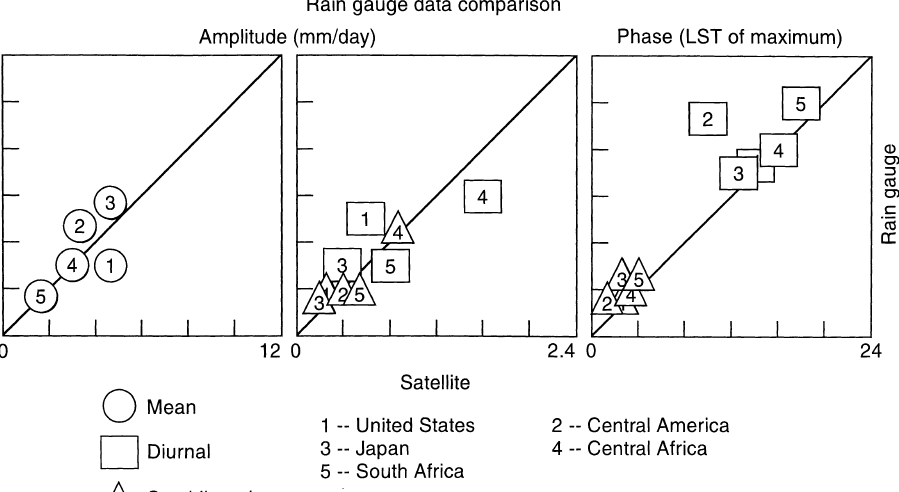
Fig. 5. Comparison of regional- mean components (diurnal mean, diurnal, and semidiurnal) of rainfall rate obtained from satellite-based cloud brightness temperature mea- surements, and from ground-based rain gauge instruments. The former represent 7-year means, and the latter usually represent >10-year means, as indicated in Table 2. The five geographic regions chosen for comparison are defined in